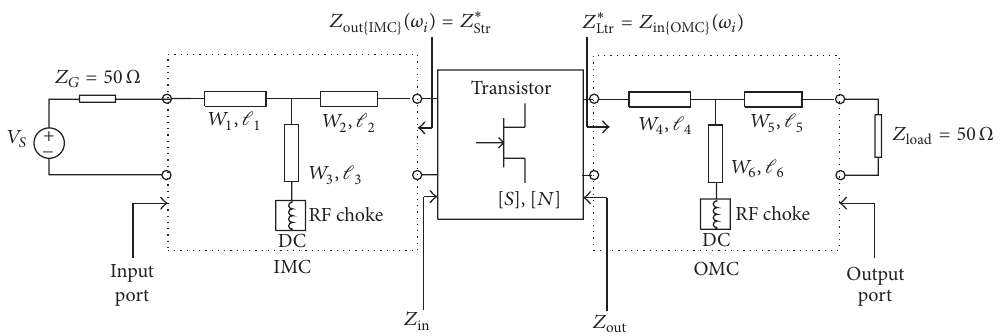
Figure 1: Low noise amplifier with 𝑇 -type microstrip line matching networks.